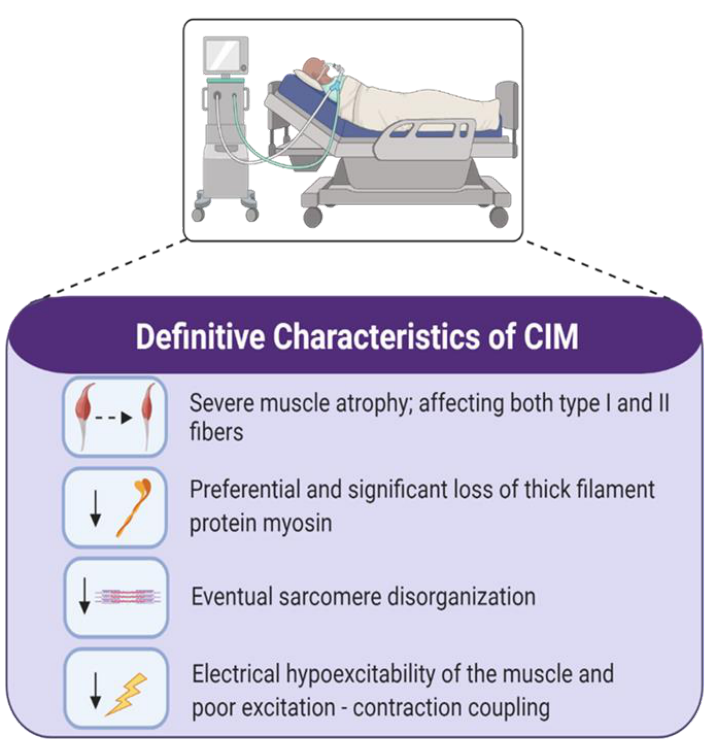
Figure 1. Changes seen in patients with definite critical illness myopathy (CIM) leading to intensive care unit-acquired weakness. CIM is almost exclusively associated with severe atrophy, preferential loss of myosin, and altered muscle cell